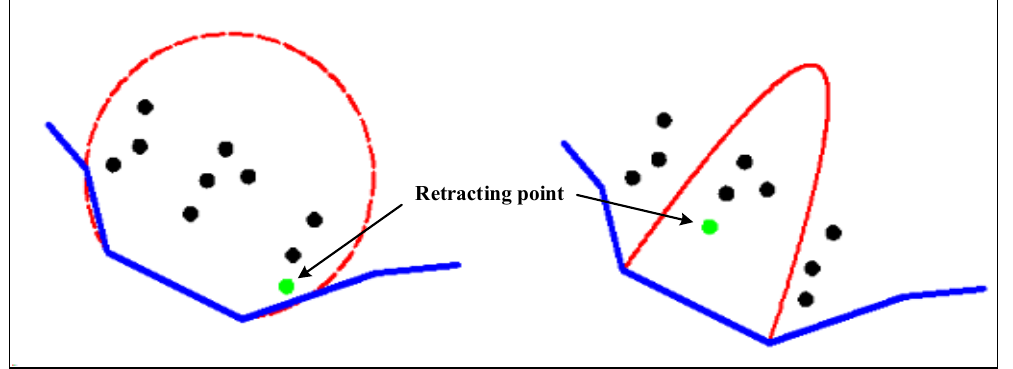
Figure 3. The same retracting depth at a different limiting condition.